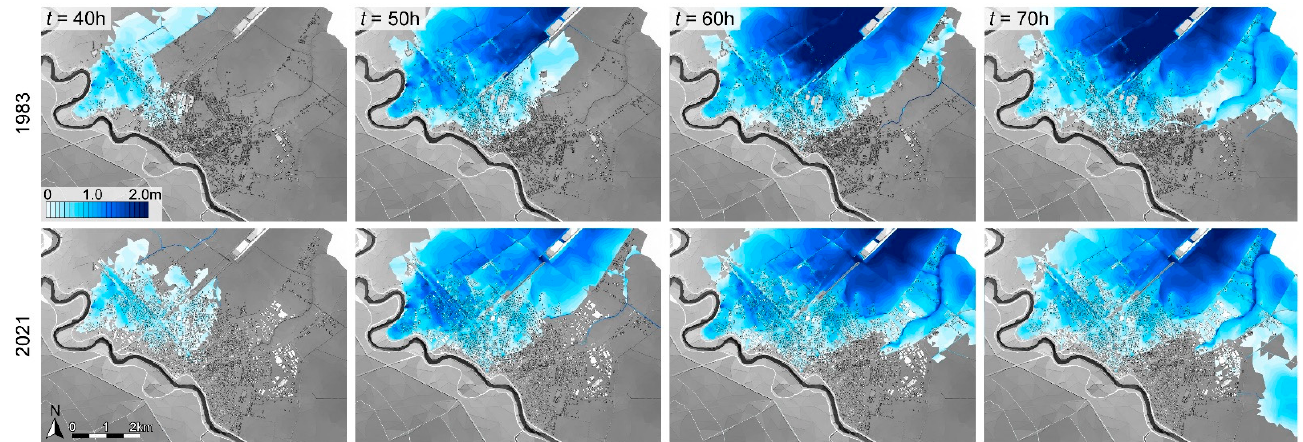
Figure 6. Spatial distribution of the water depth, Y , during the flooding event in the 1983 layout ( upper panels) and in the 2021 layout ( lower panels).